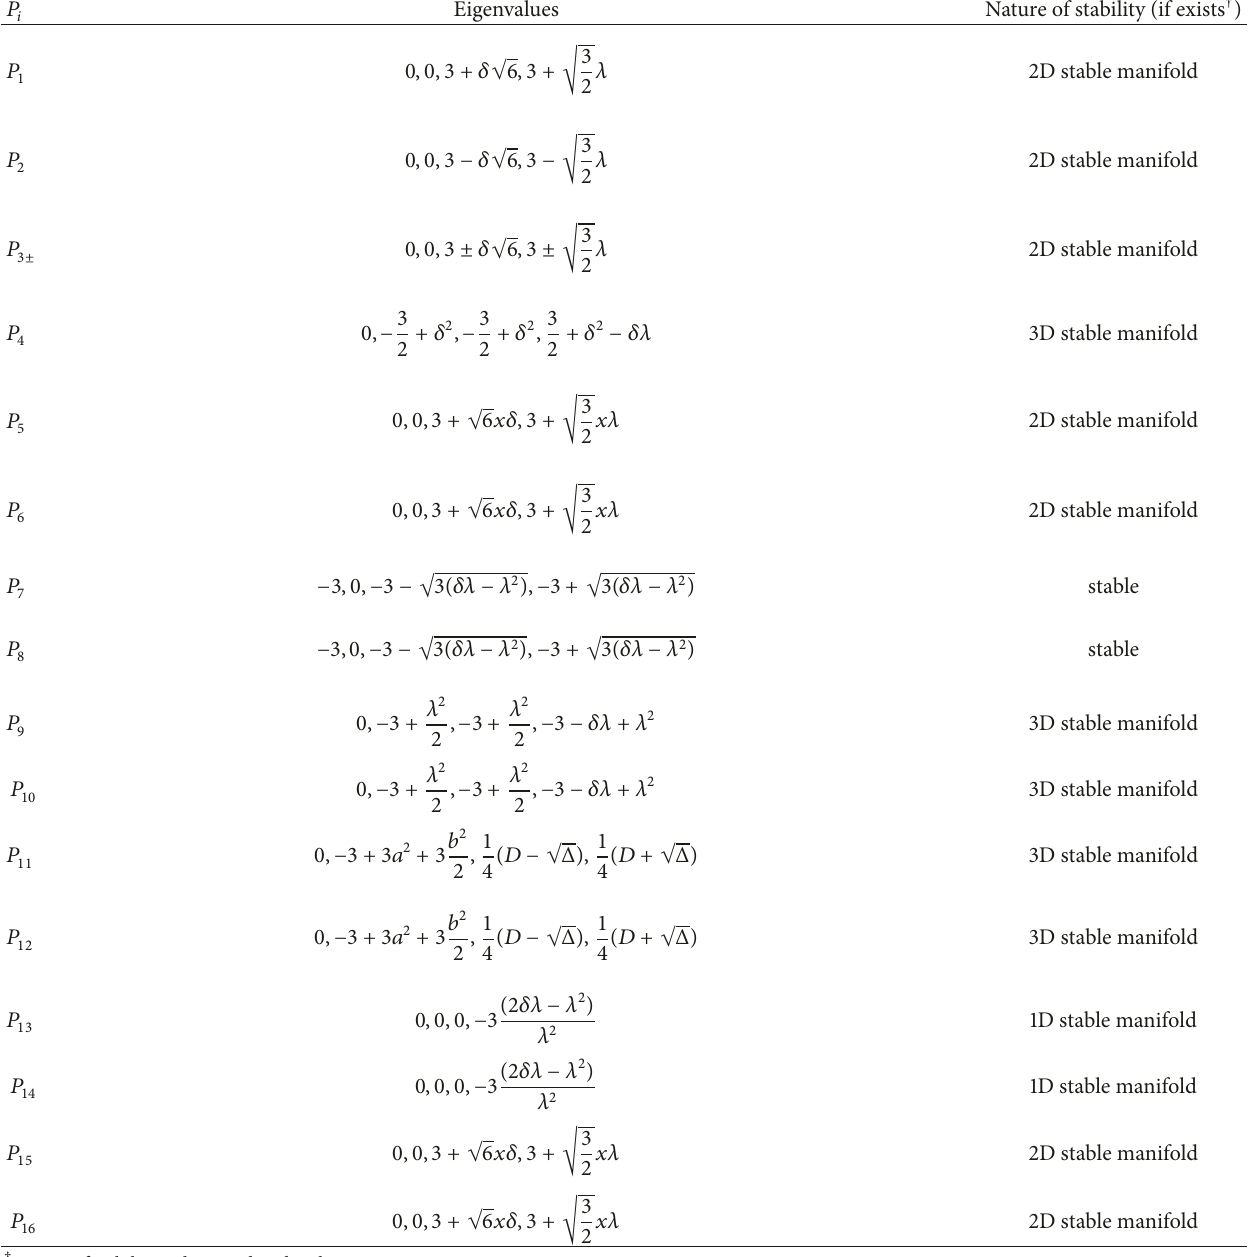
Table 2: Eigenvalues of the fixed points of the autonomous system of equations (23) and the nature of stability (if any), where 𝐷 = −12 + 24𝑎 2 + 12𝑏 2 + 2√6𝑎𝛿 + √6𝑎𝜆 and Δ = −144𝑎 2 + 144𝑎 4 + 144𝑎 2 𝑏 2 + 36𝑏 4 + 48√6𝑎𝛿 − 48√6𝑎 3 𝛿 − 72√6𝑎𝑏 2 𝛿 + 24𝑎 2 𝛿 2 − 72√6𝑎𝜆 + 72√6𝑎 3 𝜆